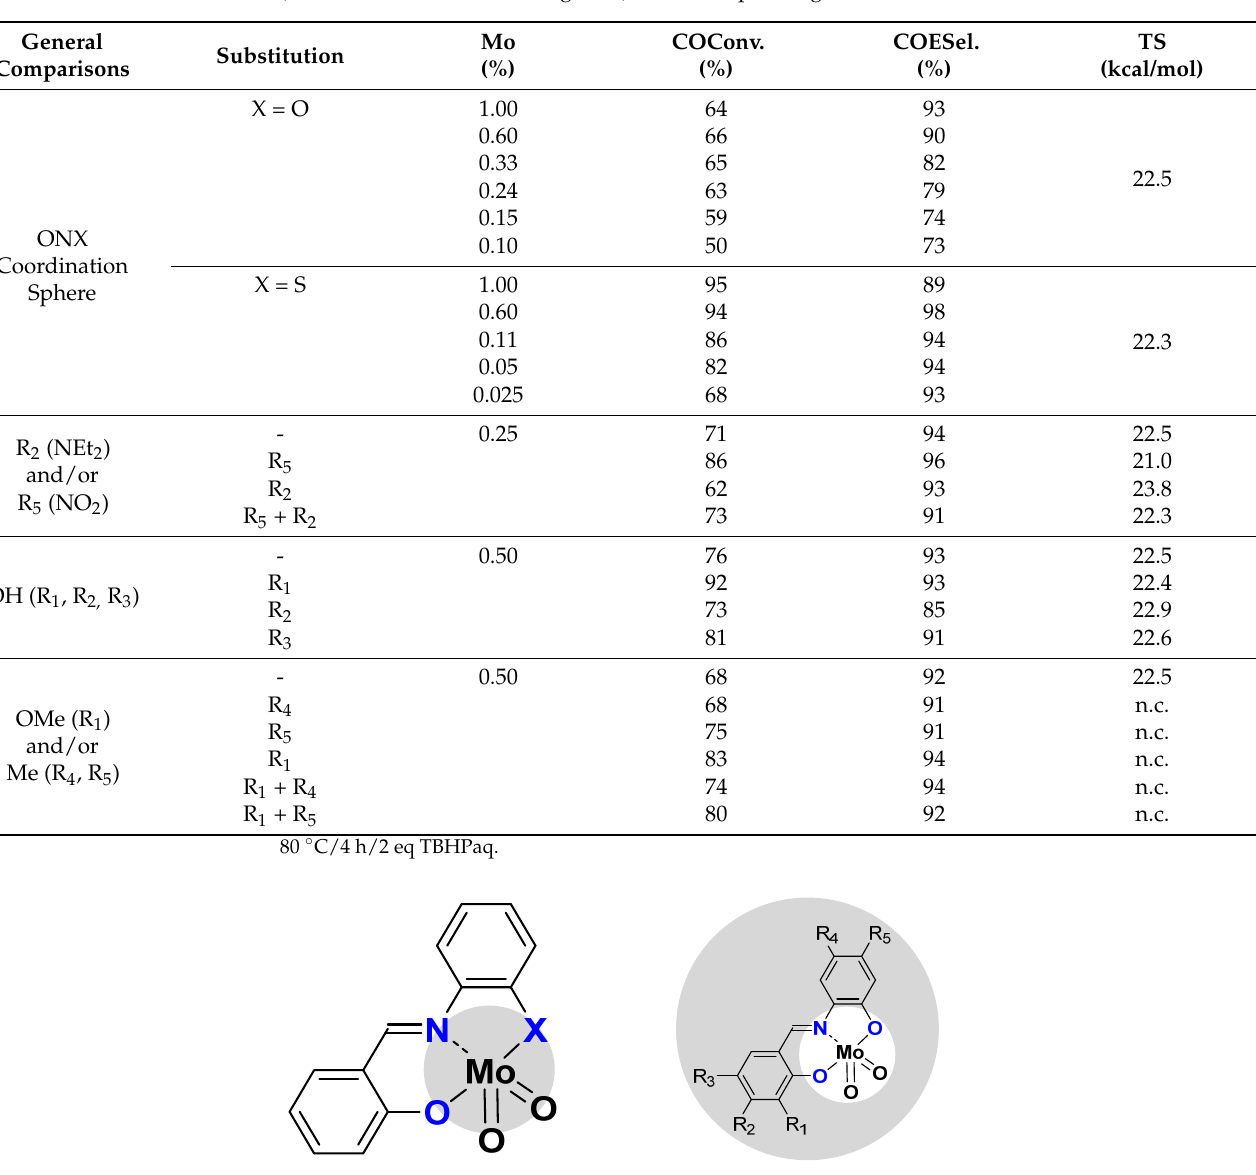
Table 1. Results of cyclo-octene (CO) epoxidation under organic solvent-free conditions and selectivity towards cyclo-octene epoxide (COE) after 4 h. Comparison of first and second sphere influence (Structures are those from Figure 4) and corresponding transition state.